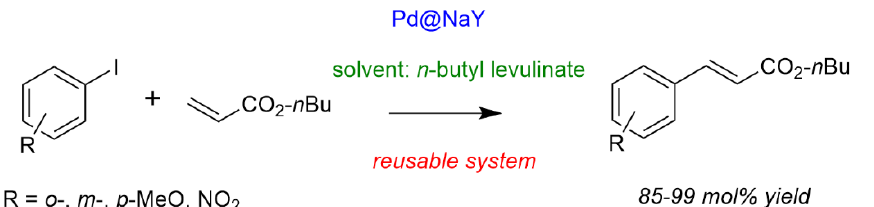
Figure 4. Example of lignin structure highlighting the diversity of constituting units and interunit